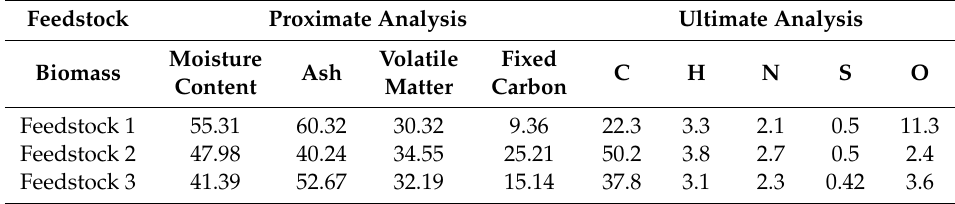
Table 3. Analysis of the agro biomass feedstock used in this research [56] .